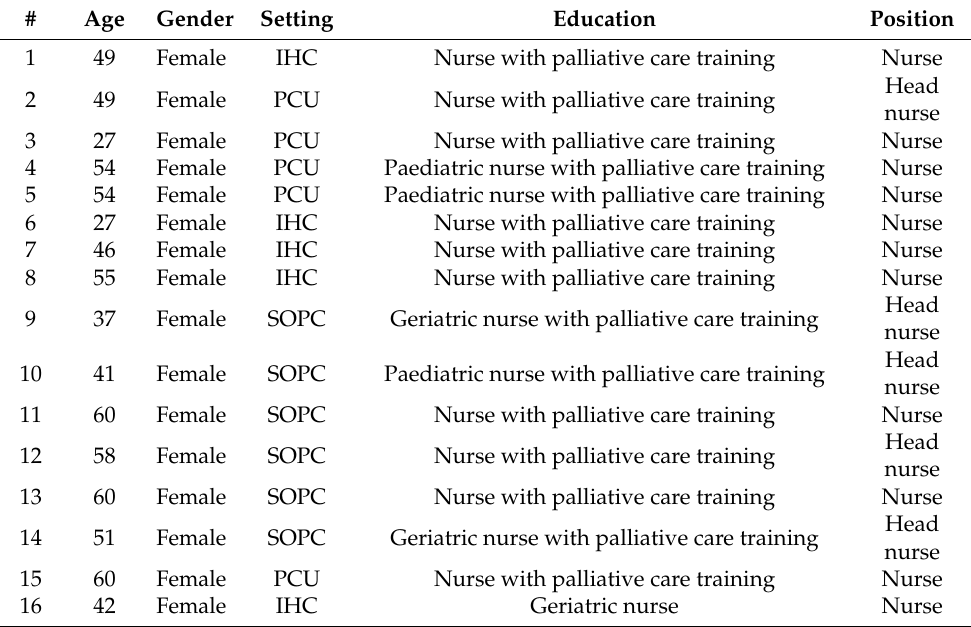
Table 1. Expert interviews sample